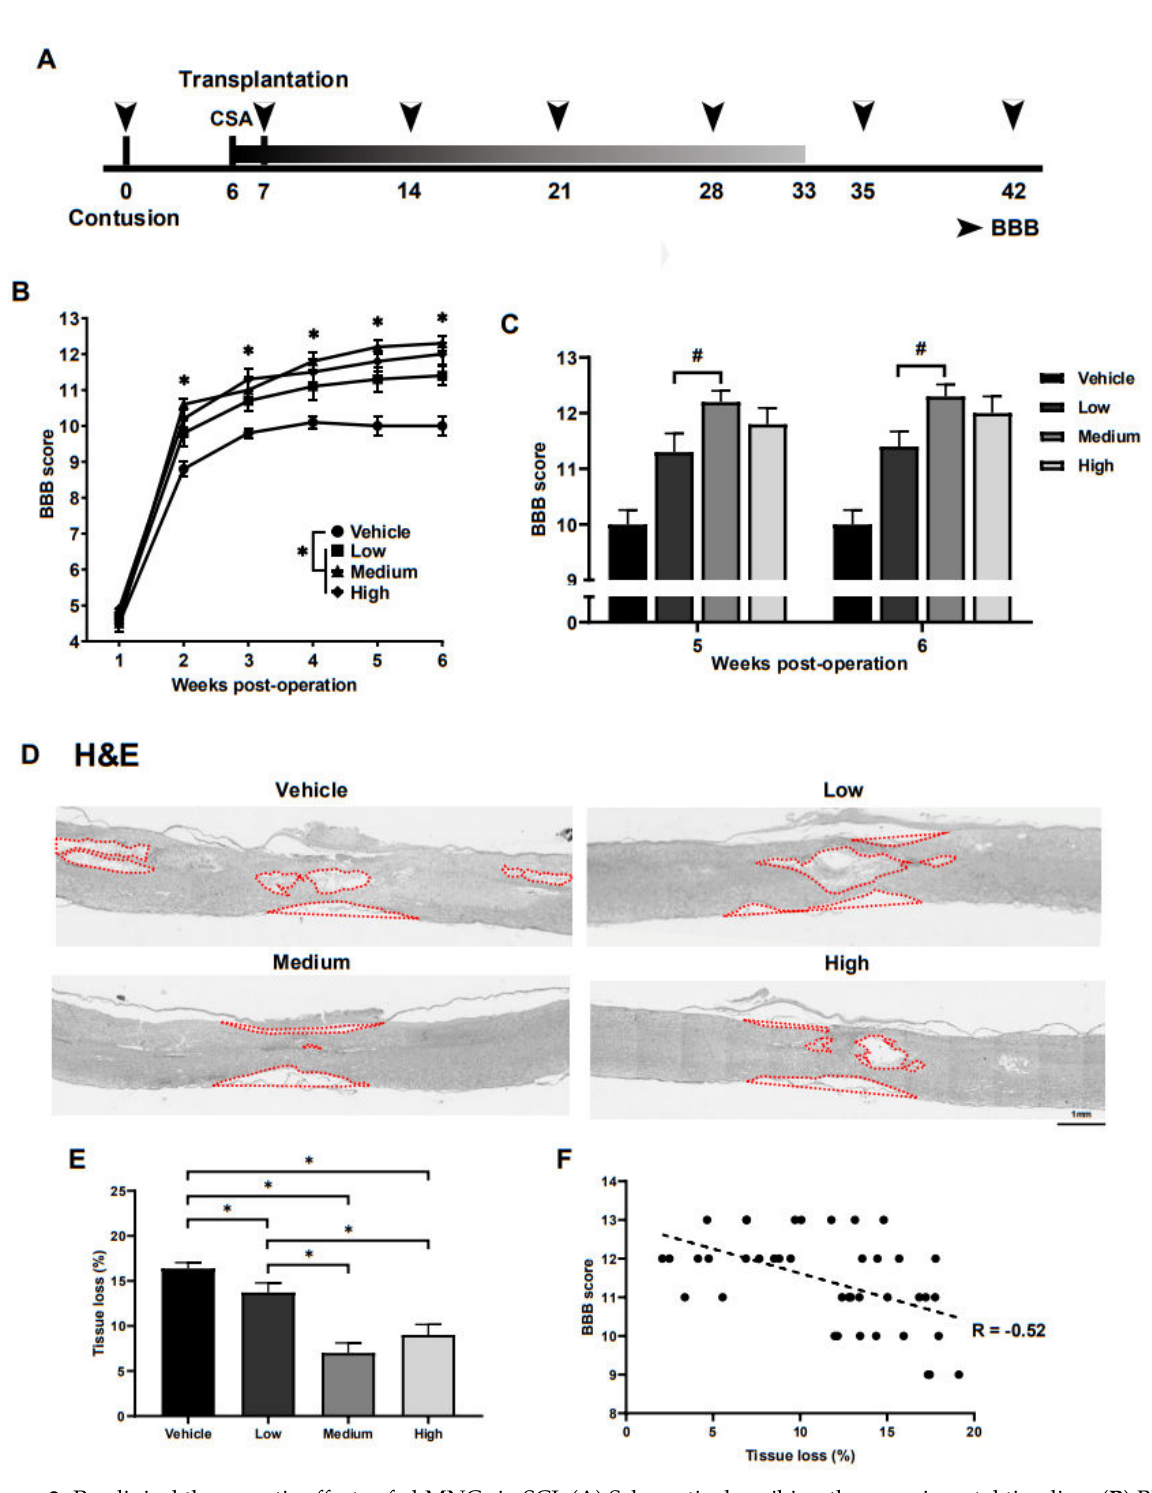
Figure 2. Preclinical therapeutic effects of ahMNCs in SCI. ( A ) Schematic describing the experimental timeline. ( B ) BBB scores were monitored once a week until 6 weeks post SCI. ( C ) The BBB scores at 5 and 6 weeks after SCI were compared. ( D ) Tissue loss was evaluated using histological methods at 6 weeks post SCI. Red lines delineate the contours of the lost tissue including both cavities and shrunken tissue. Scale bar = 1 mm. ( E ) Relative areas of tissue loss were quantified and then compared. ( F ) Correlation analysis revealed a significant negative relationship between the degree of tissue loss and the BBB score. Height = Average, Error bar = Standard Error. *, # P <